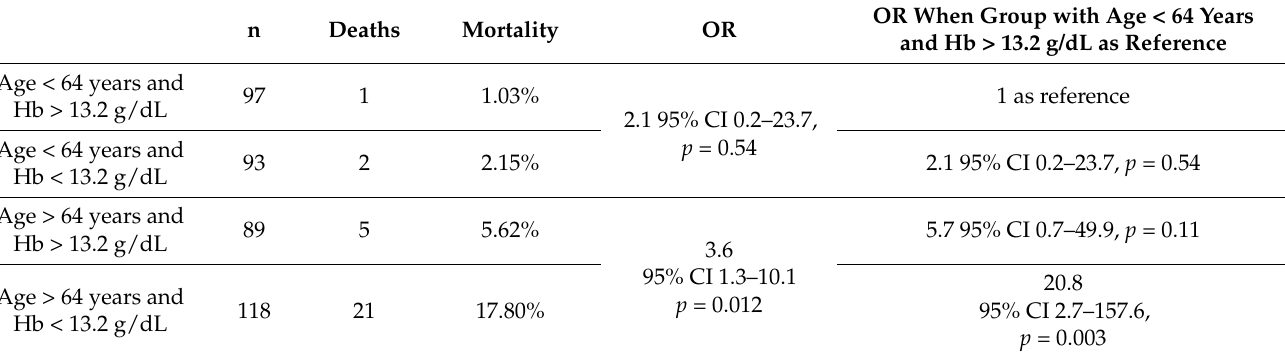
Table 2. Prognostic value of age and hemoglobin levels in PE